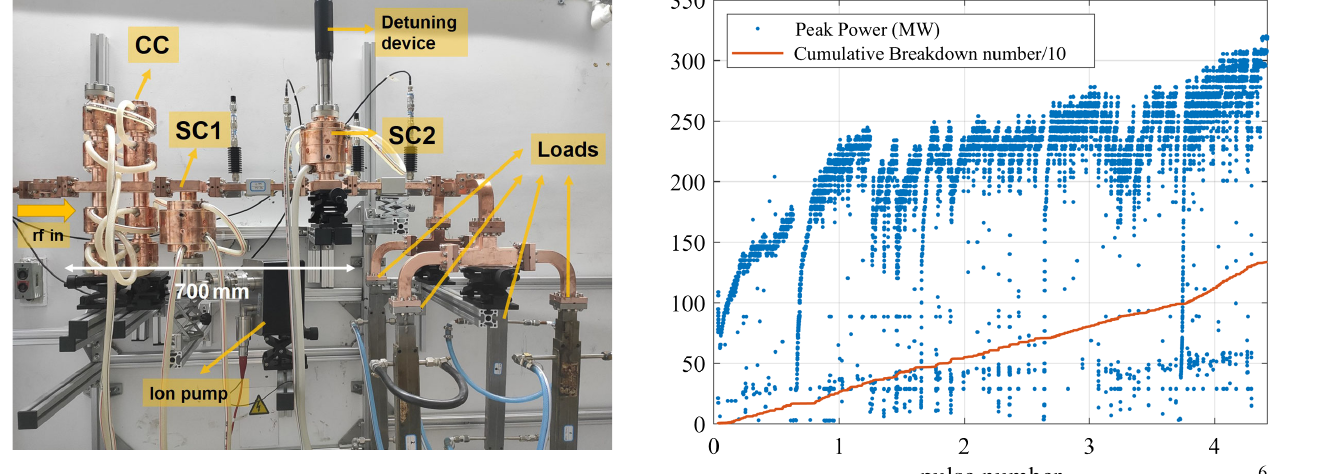
FIG. 13. Photograph of the pulse compression system with four stainless steel loads after installation.